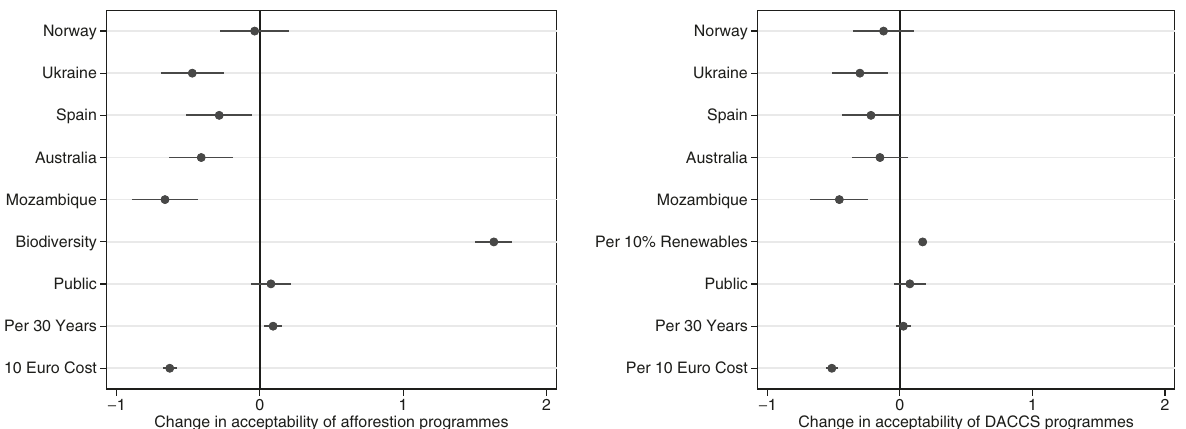
Fig. 4 Effects of carbon dioxide removal (CDR) characteristics on acceptability of CDR methods. Presented on the y -axis are the effects (dots and 95% CIs) of vignette attributes (country, environmental characteristics, public vs. private, guaranteed permanence of storage, and costs to households, compare Table 1) on changes in support measured on a 11-point scale ( x -axis). The results are based on random effects models; n = 5067 vignette evaluations per CDR method from n = 1689 respondents. Positive effects refer to an increase in acceptability and negative effects to a decrease. The effects for the categorical variables (country, public vs private, biodiversity) are relative to the respective base category (Germany, monoculture, private actor). For full regression tables see Tables S1 and S2 in the suppl.